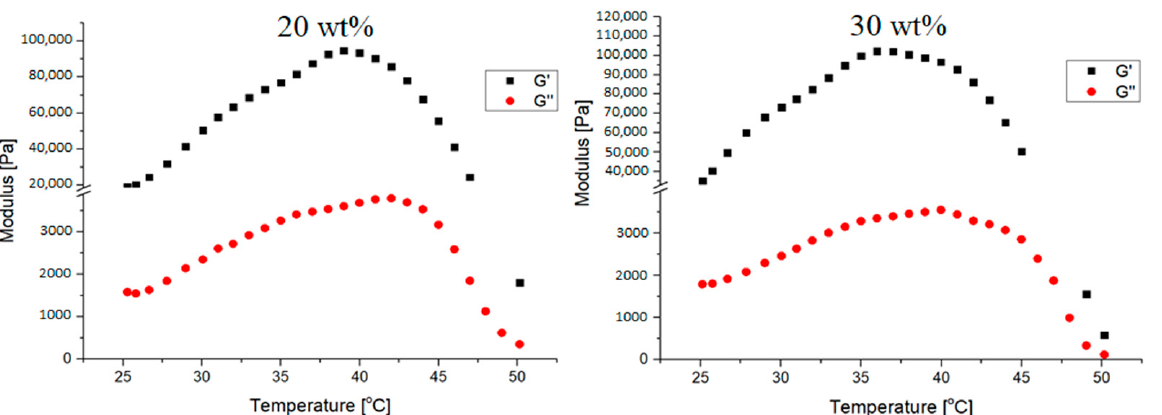
Figure 9. The G' and G” moduli of PCEC-A2.0 aqueous solutions as a function of tem- Figure 9. The G (cid:48) and G (cid:48)(cid:48) moduli of PCEC-A2.0 aqueous solutions as a function of perature.